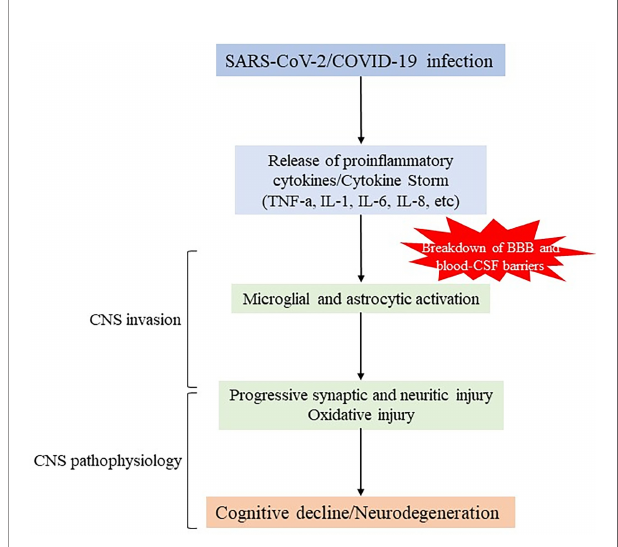
FIGURE 1 | Schematic representation of potential mechanisms of SARS- CoV-2 infection in neurodegeneration. SARS-CoV-2 infection causes